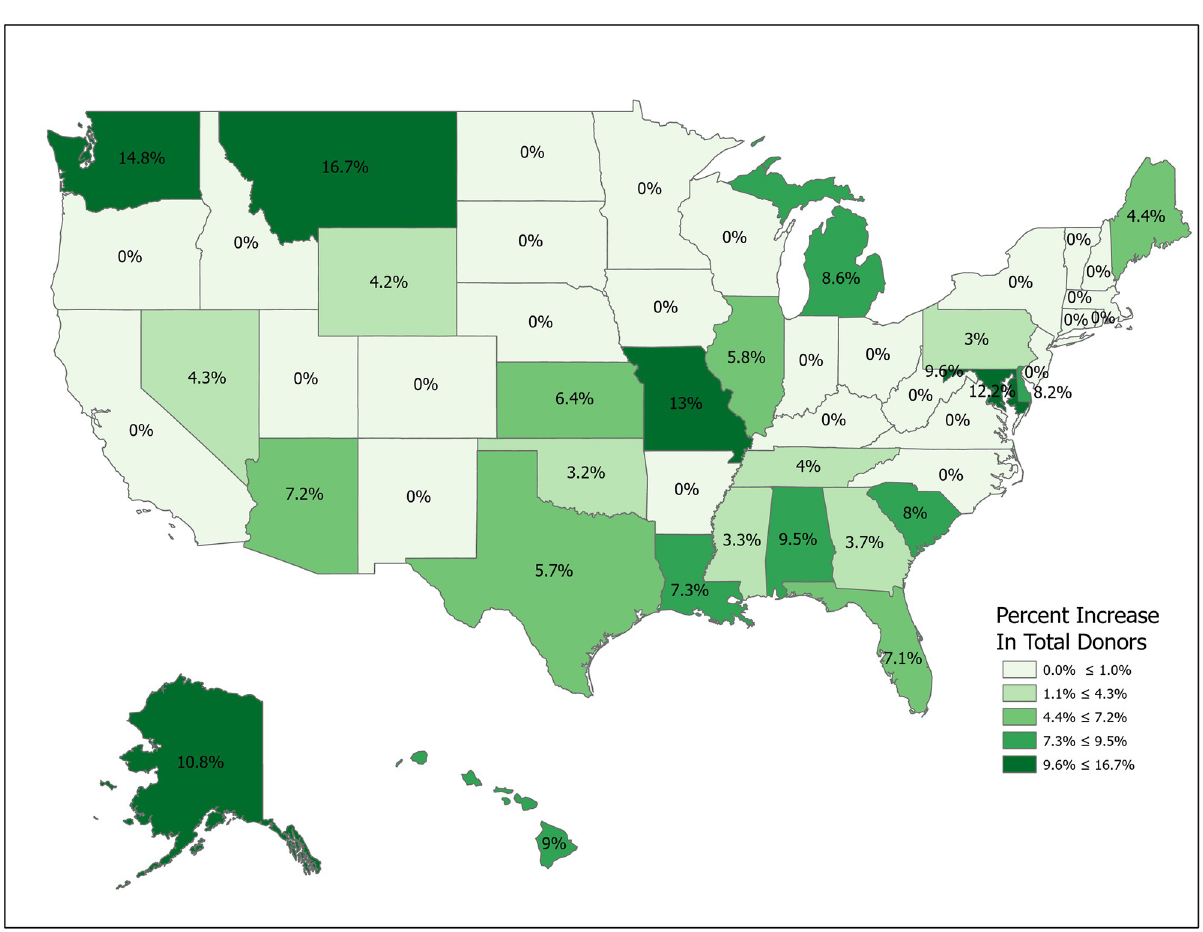
Fig 11. Simulation 5: Target states with high potential donor death rates ( q 1 ). Data come from Table 6. Maps created by ArcGIS Pro, URL: https:// www.esri.com/en-us/arcgis/products/arcgis-pro/overview. Base Map: World Light Gray Base, URL: https://services.arcgisonline.com/arcgis/rest/